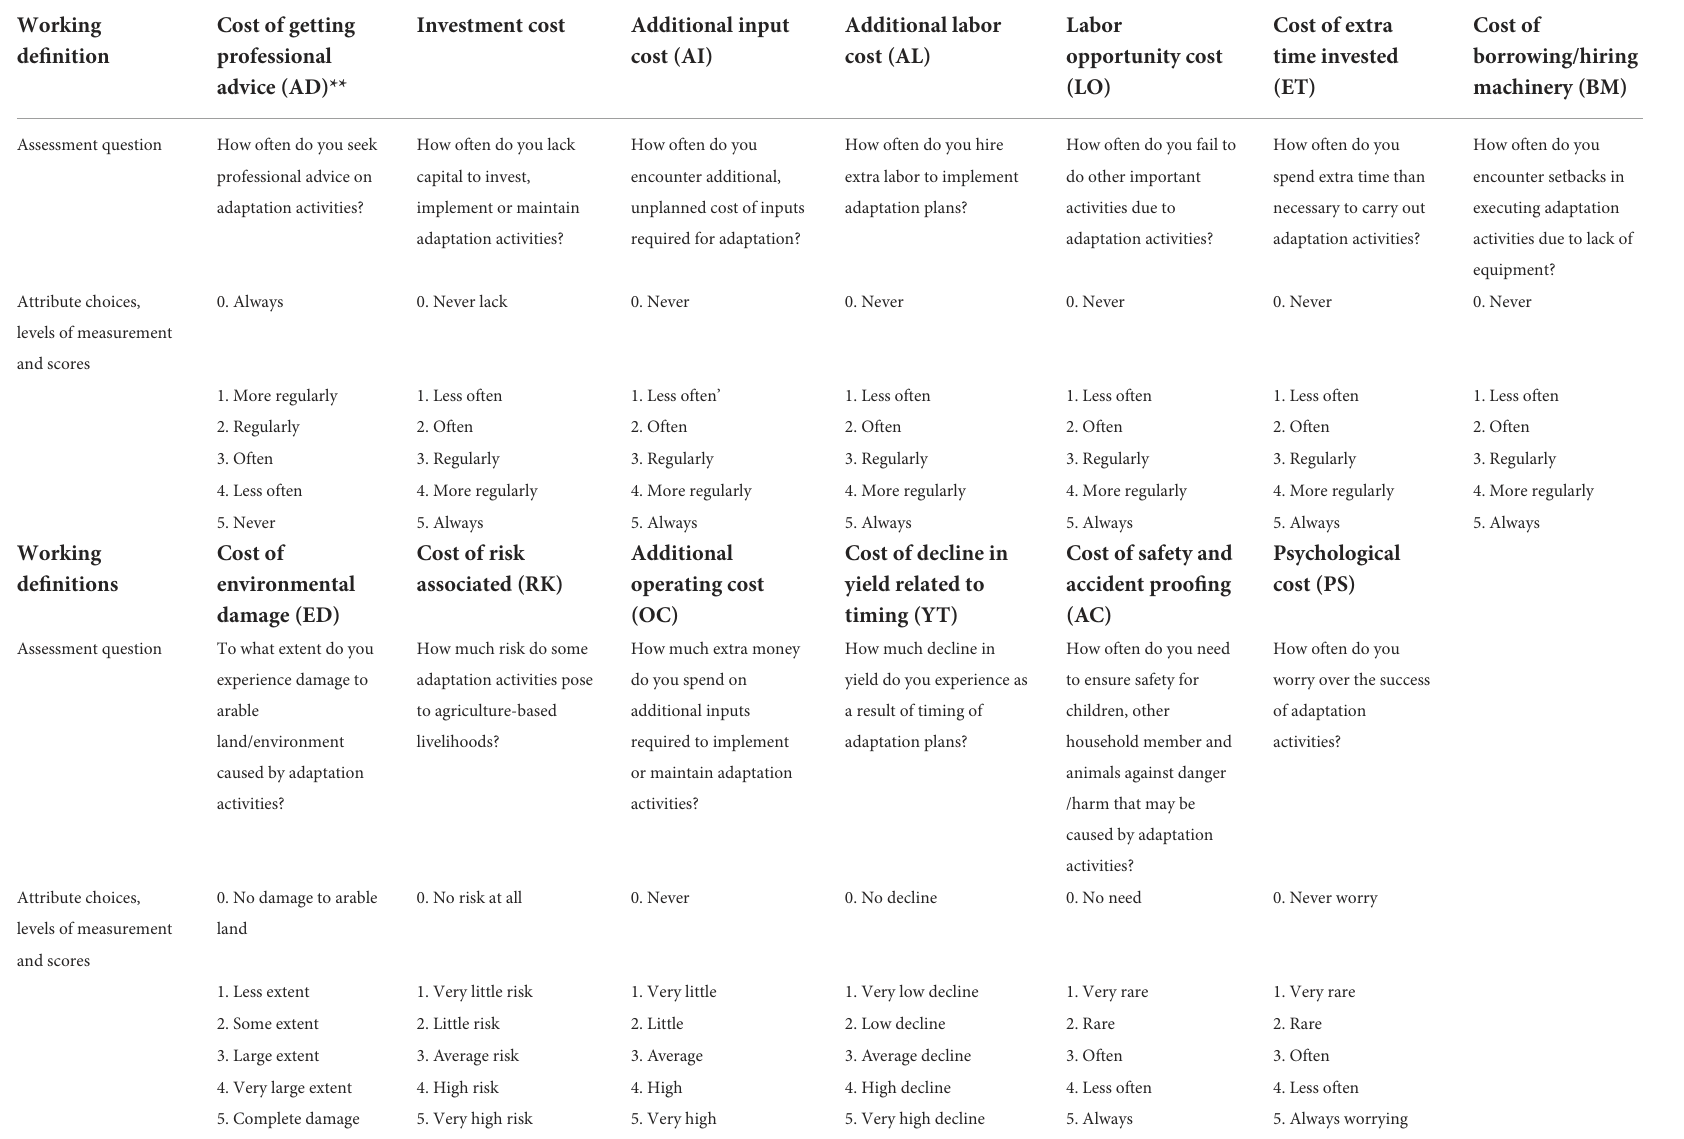
TABLE 6 Evaluation tool for estimating cost